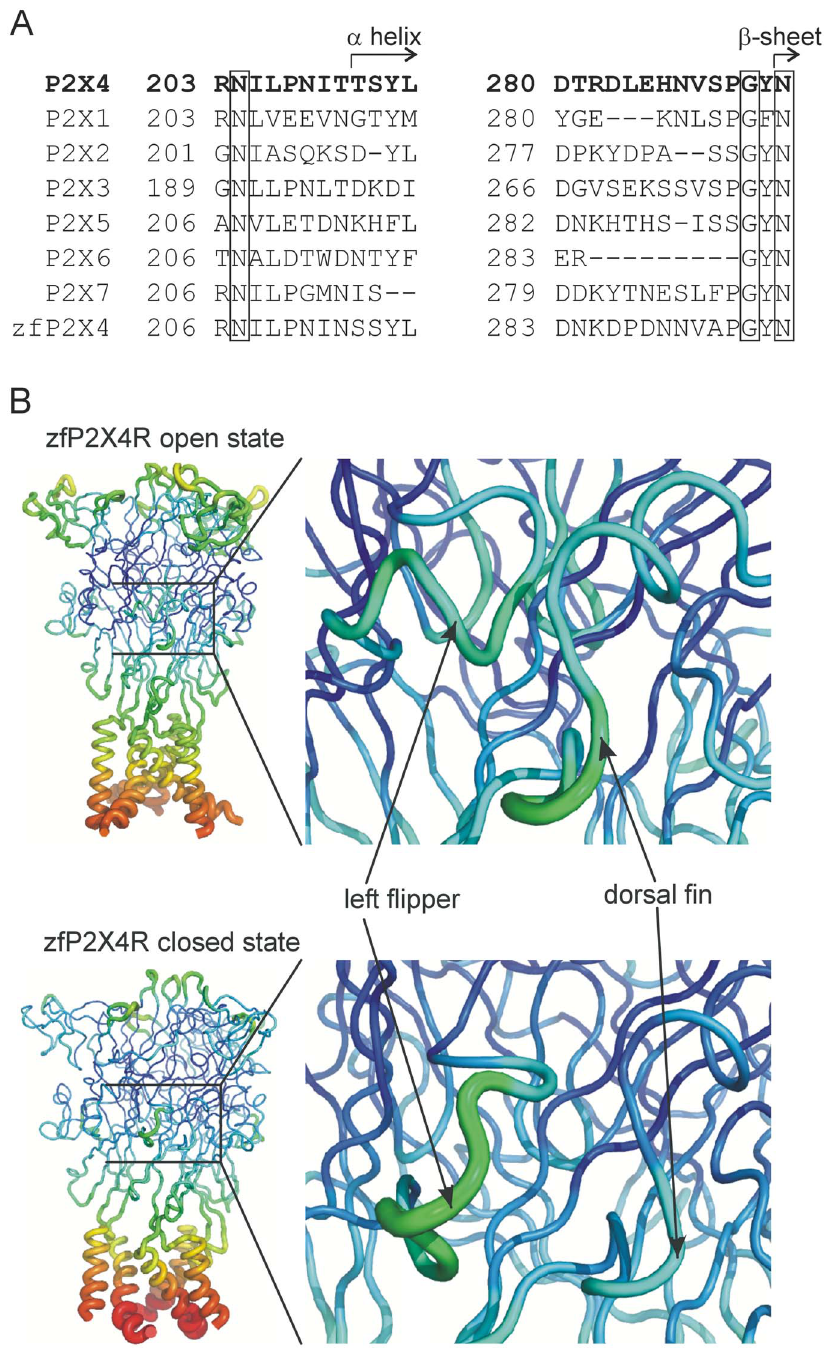
Figure 1. Structural and tridimensional organization of the DF and LF domains. (A) Alignment of amino acid sequences from R203-L214 (DF domain) and D280-N293 (LF domain) using seven rP2X and zfP2X subunits. Structurally, these regions are composed of random coils that terminate with short a -helix and b -sheet structures (indicated by arrows). Conserved amino acid residues are shown in boxes. (B) The models of the zfP2X4.1R are shown in the open (4DW1) or closed (4DW0) state, and the Debye-Waller factor (B-factor) indicates the degree to which the electron density is spread (miniatures). The model shows the elevated B-factor values within the region of intersubunit interaction (magnified segments). Higher B-factors are indicated with thicker cylinders and a red-shifted color, while the lowest B-factors are represented with the thinnest cylinders and a blue-shifted color. doi:10.1371/journal.pone.0112902.g001 induced by 100–1000 m M ATP, EC 50 is the agonist concentration Inc., Chicago, IL). Hill coefficient was fixed to 1.3 in all producing 50% of the maximal response, h is the Hill coefficient, experiments, a value obtained for the WT receptor by fitting. The kinetics of deactivation (current decay evoked by washout of and x is the concentration of ATP (SigmaPlot 2000 v9.01; SPSS